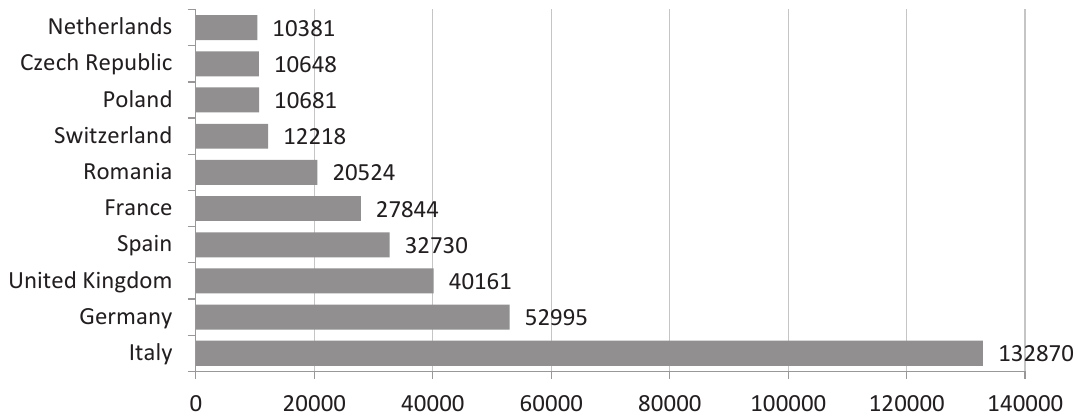
Figure 3. The number of the registered certificates in the European countries – 10 top countries